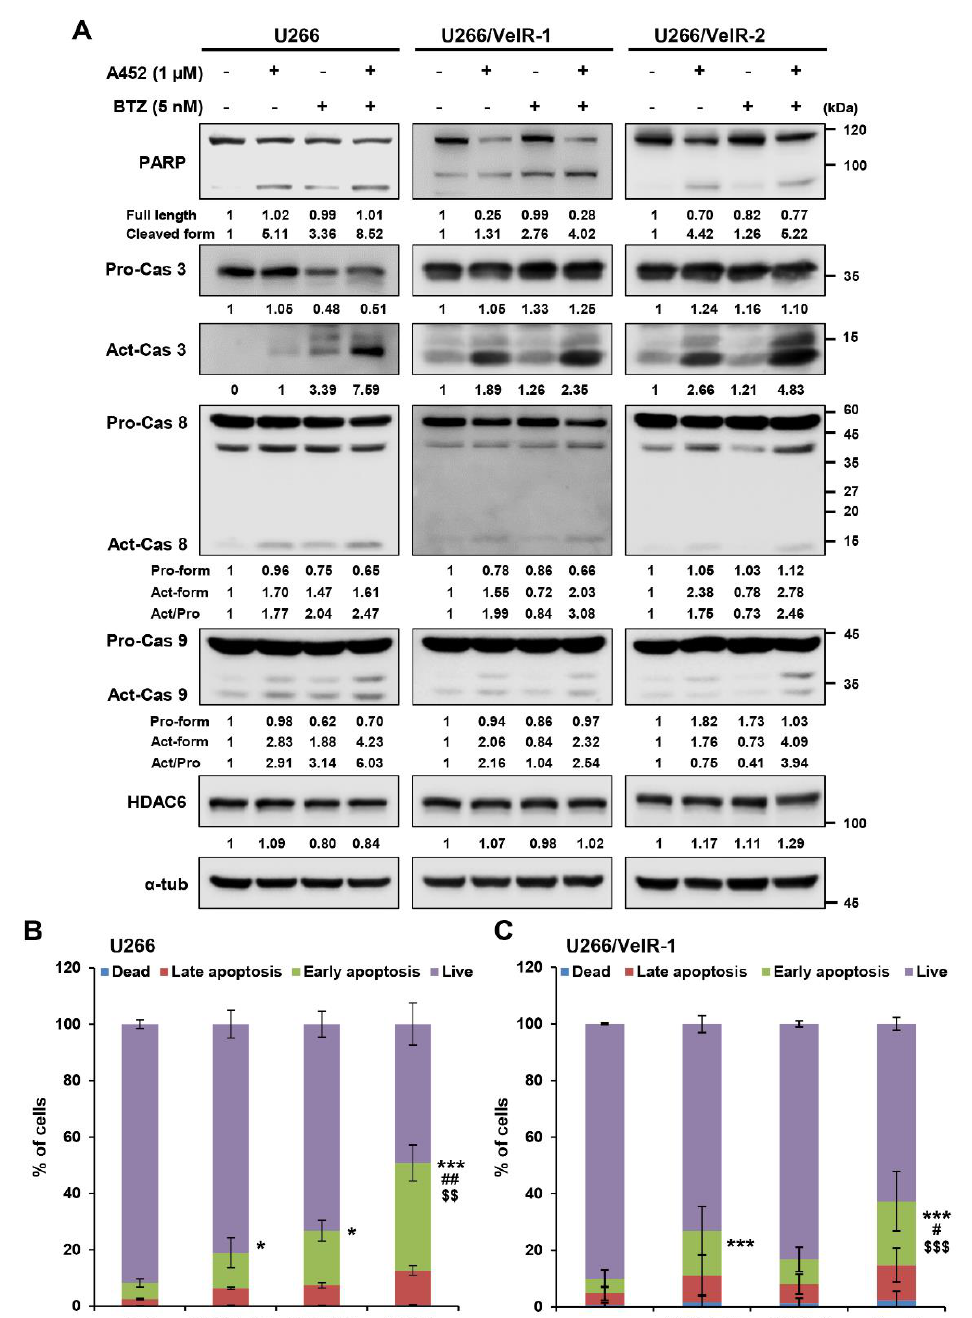
Figure 4. Cotreatment with BTZ and A452 leads to synergistic apoptosis induction in both BTZ-sensitive and BTZ-resistant U266 MM cells. ( A ) BTZ-sensitive U266 and BTZ-resistant U266 (U266/VelR-1 and U266/VelR-2) MM cells were treated with 0.1% DMSO (control), A452 (1 μM), and BTZ (5 nM) or in combination with these compounds as indicated for 24 h. Apoptotic markers were identified by immunoblotting using whole-cell lysates. α-tubulin was used as an equal loading control. The abundance of the indicated proteins was semi-quantified relative to α-tub; control levels were set at 1. ( B ) BTZ-sensitive U266 and ( C ) BTZ-resistant U266/VelR-1 cells were treated with 0.1% DMSO (control), A452 (1 μM), and BTZ (5 nM) or in combination with these compounds as indicated for 36 h. Cell death was assessed by flow cytometry and Annexin V/PI staining. Data present as mean ± SD ( n = 3). * p < 0.05 and *** p < 0.001 vs. DMSO control, $$ p < 0.01 and $$$ p < 0.001 vs. BTZ-treated group, # p < 0.05 and ## p < 0.01 vs. A452-treated group; two-way analysis of variance (ANOVA) test.